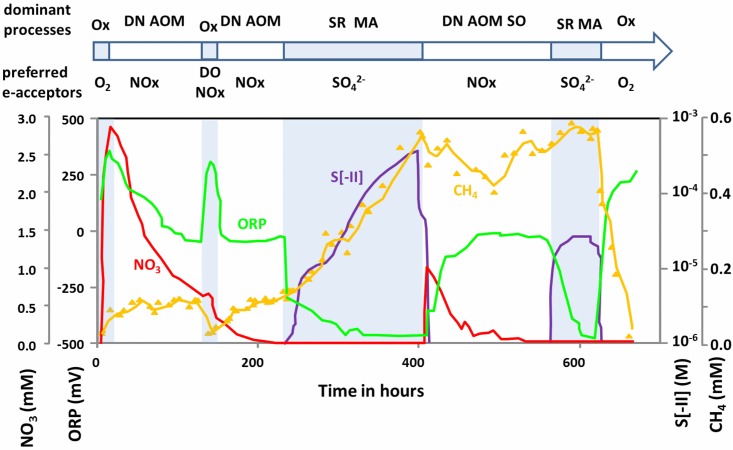
Hydrochemical changes in the overlying water of an incubated sediment core during redox succession.The time line above indicates the different microbial phases within the experiment and highlights the preferred electron acceptors within these phases. Ox: Oxygen consumption; DN: Denitrification; AOM: anaerobic oxidation of methane; MA: Methane Accumulation; SR: Sulfate Reduction; SO: Sulfide oxidation.